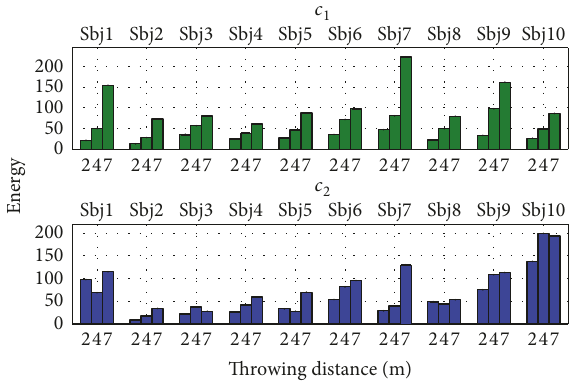
Figure 18: Combination coe ffi cient energy per subject and